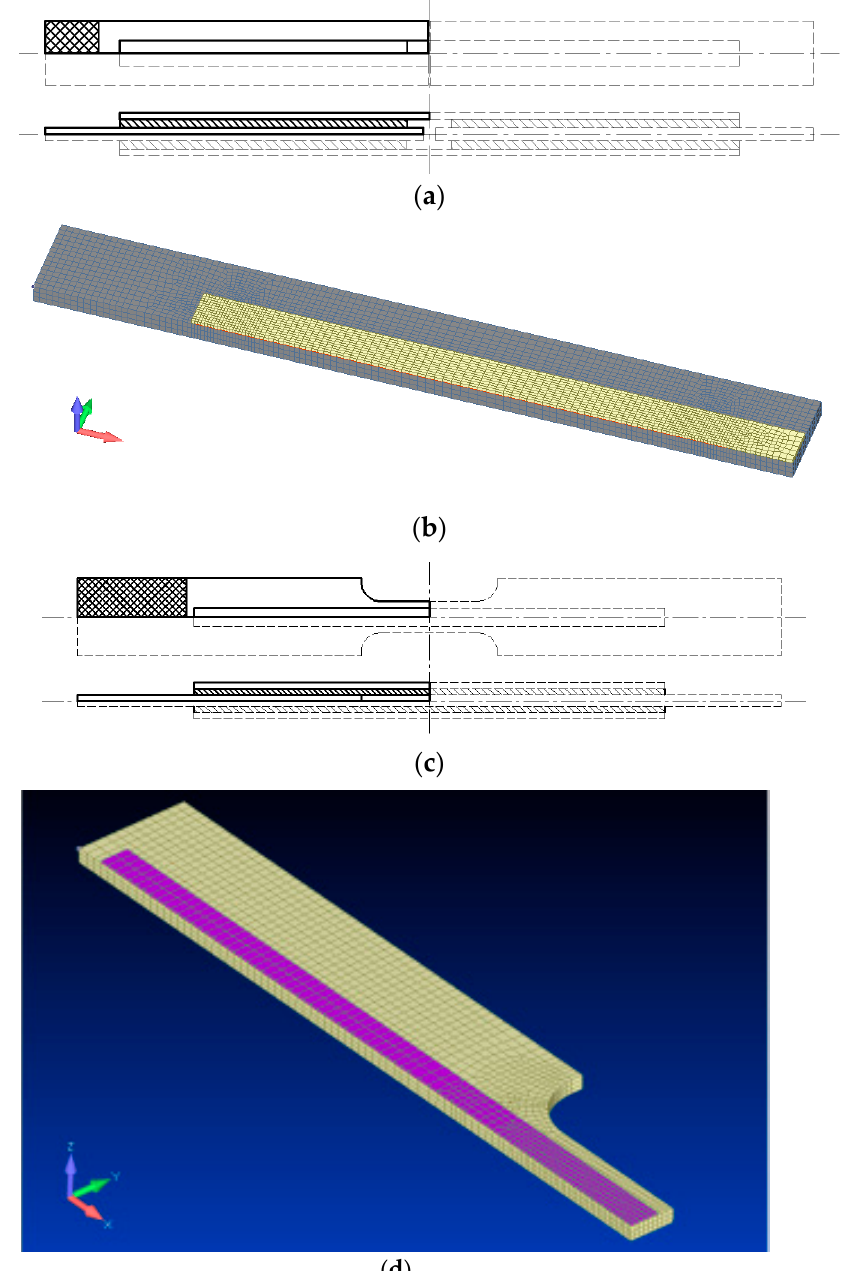
Figure 8. Parts of experimental specimens, used for calculation purposes, and their FEM models: ( a ) The design area of the specimen for the adhesive layer testing; ( b ) the FEM model of the design area of the specimen for the adhesive layer testing; ( c ) the design area of the strengthened specimen; ( d ) the FEM model of the design area of the strengthened specimen.